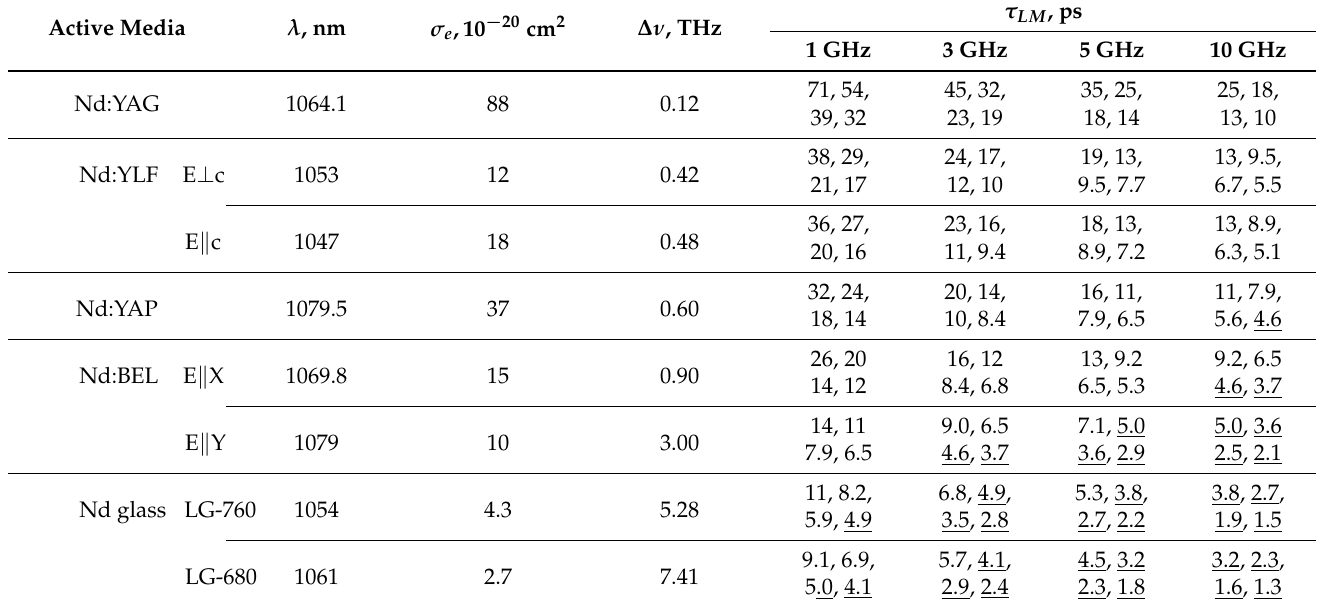
Table 1. Pulse duration τ LM estimated for typical Nd-based active media [32] with modulation depth a = 25%, 50%, 100%, 150%. λ is wavelength, σ e is emission cross-section, and ∆ ν is emission bandwidth. G = 1.5, S = 0.3.